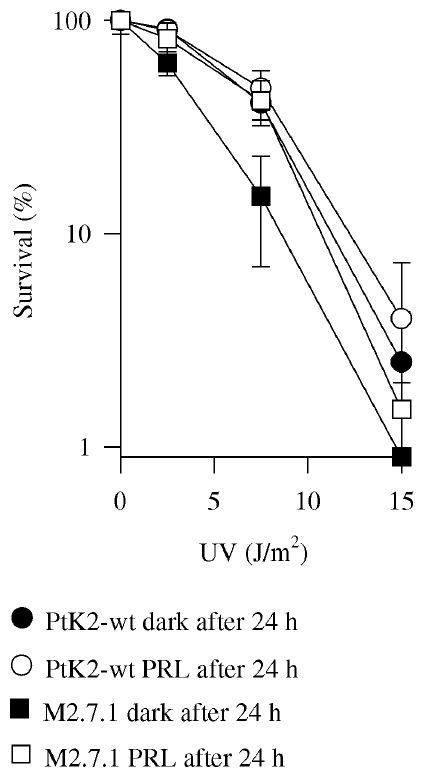
Figure 1 - UV survival of the M2.7.1 mutant. PtK2 parental cell line (circles) and M2.7.1 (squares) cells were irradiated with UV, maintained in the dark for 24 h, then exposed (open symbols) or not (closed symbols) to photo- reactivating light (PRL). Clones were scored for cell survival 14 days after plating. wt, Wild-type